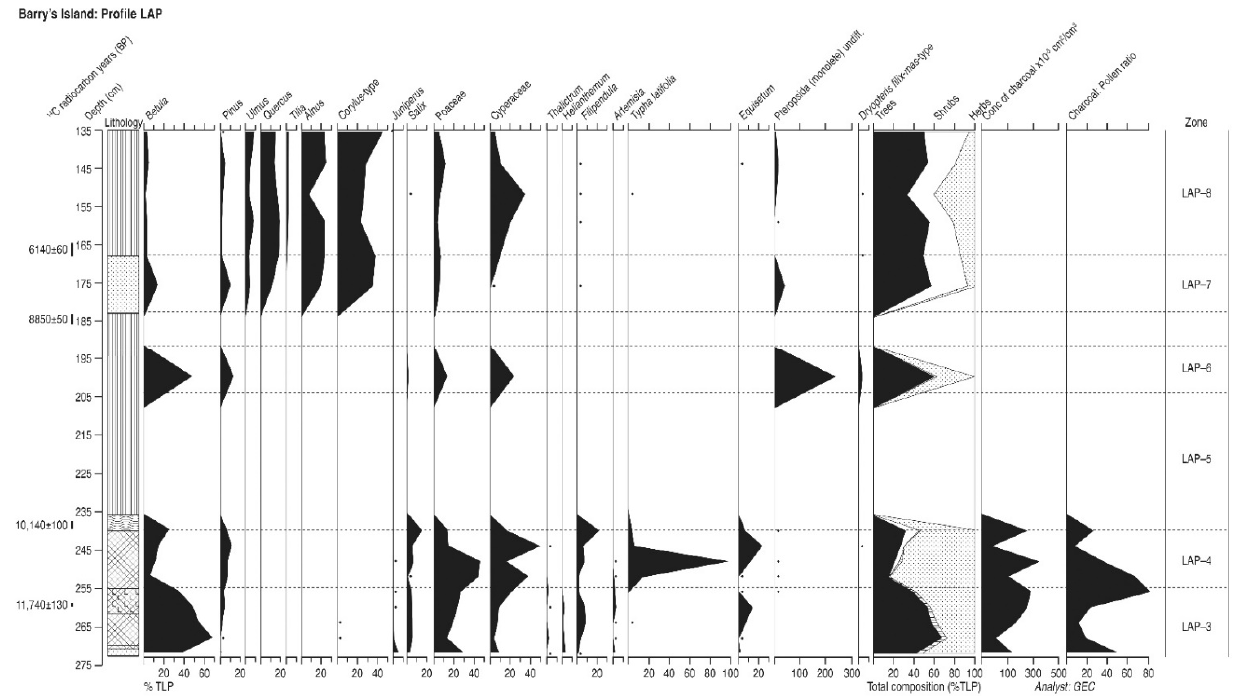
Figure 12. Percentage pollen diagram from Barry’s Island profile LAP. (Analysis